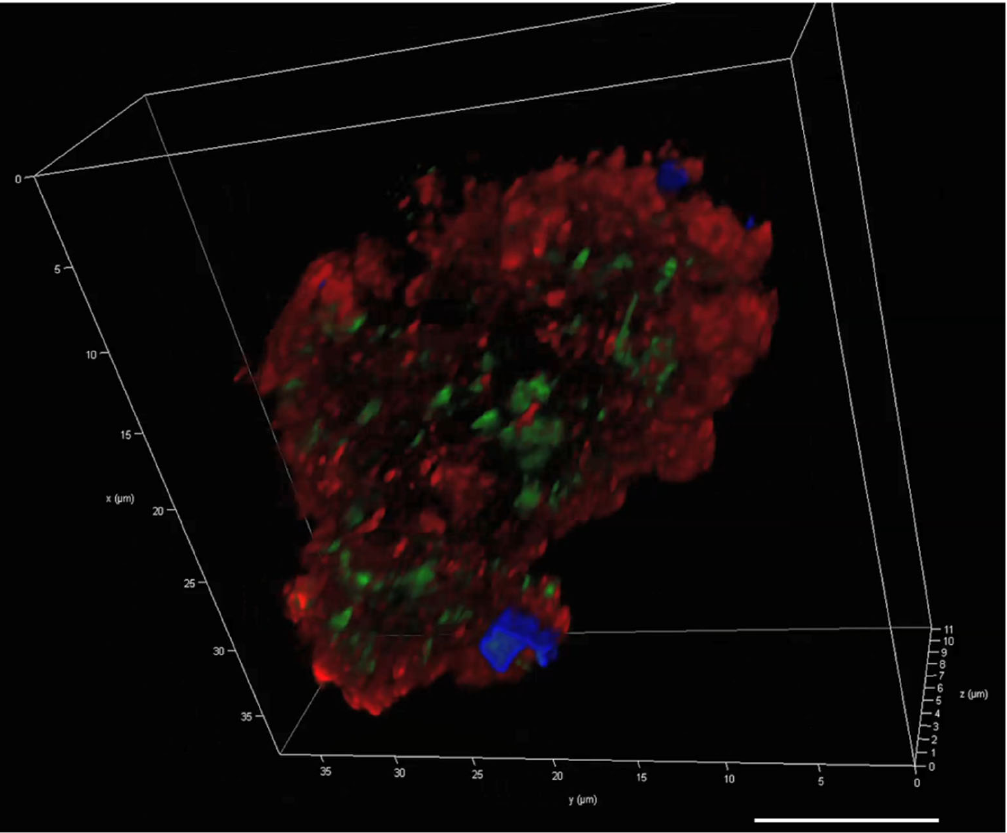
Figure 7. A 3D image of a single natural MGP stained with ConA (blue), TOTO-3 (red)-stained eDNA and SYTO 9 (green)-stained iDNA. Scale bar = 10 µm. Image captured with Leica SP8 CLSM.